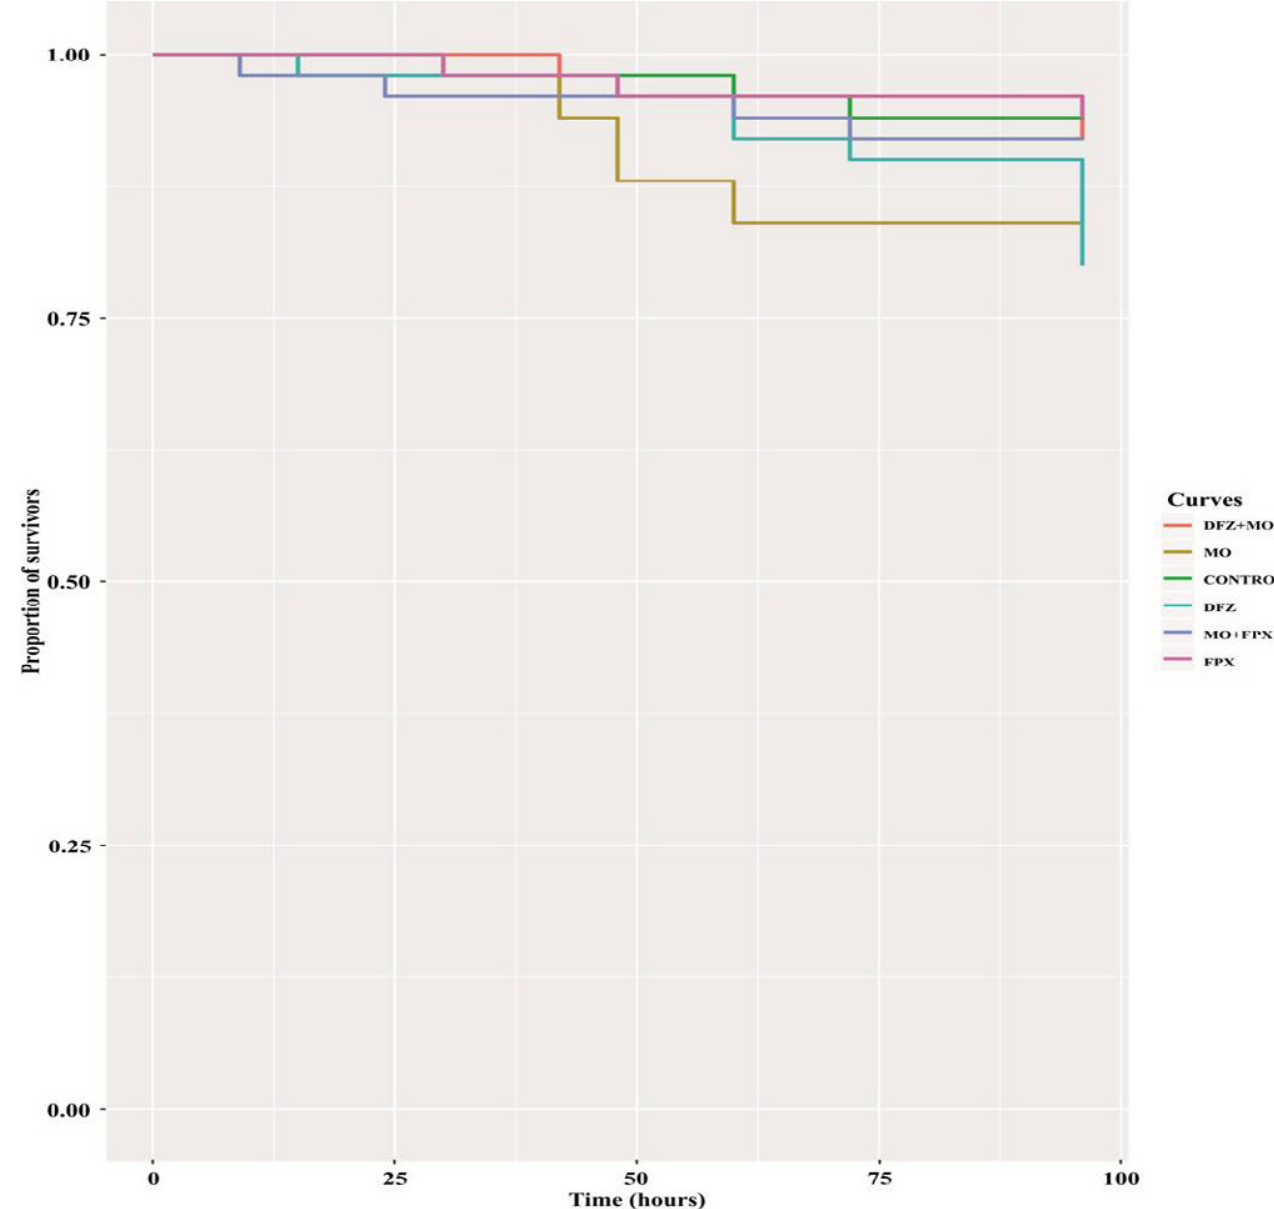
Fig 1 . Survival curves plotted from exposure time (hours) via ingestion until death of each bee ( Apis mellifera ): Difenoconazole + Mineral oil (DFZ+MO); Mineral oil (MO); Control (CONTROL); Difenoconazole (DFZ); Mineral Oil + Fenpyroximate (MO+FPX); Fenpyroximate (FPX); . Curves indicate the median and 95%,